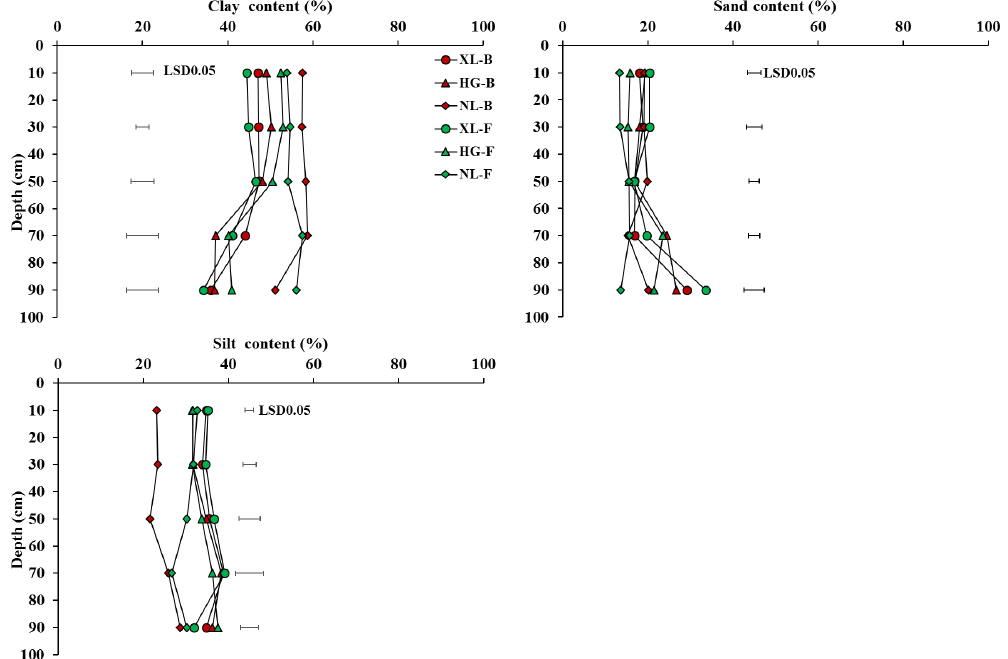
Figure 2. The distribution of soil particle-size fractions in profiles at different land use sites. Buffer of Xinglong site (XL-B); buffer of Haigeng site (HG-B); buffer of Niulian site (NL-B); crop field of Xinglong site (XL-F); crop field of Haigeng site (HG-F); crop field of Niulian site (NL-F).